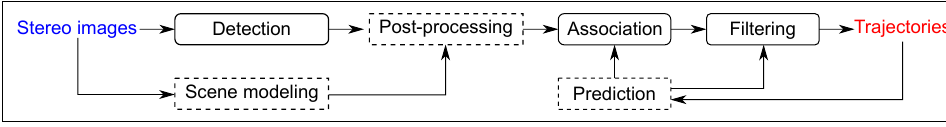
Figure 3. Our general tracking framework.